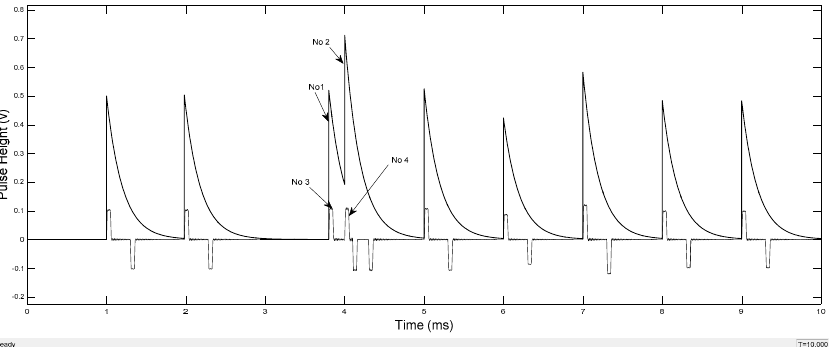
Figure 16. Pile-up 2 using the NTPS algorithm.